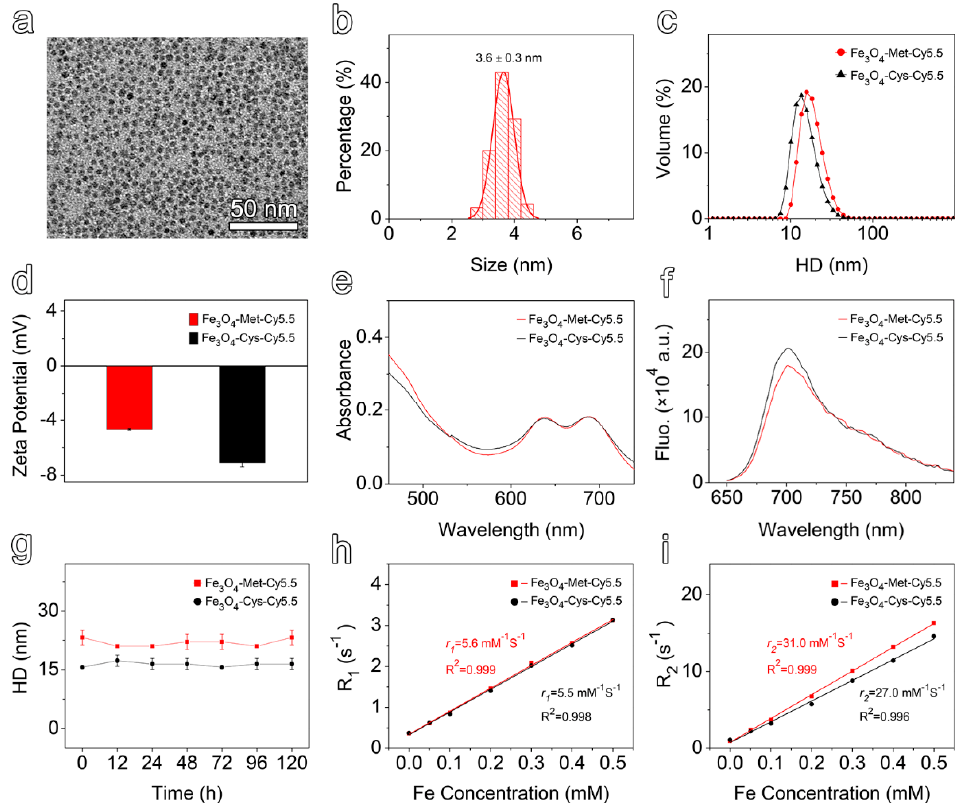
Figure 1. ( a ) TEM image and ( b ) size distribution of PEGylated Fe 3 O 4 -Mal nanoparticles. ( c ) Hydrodynamic size distribution and ( d ) zeta potential values of Fe 3 O 4 -Met-Cy5.5 and Fe 3 O 4 -Cys-Cy5.5. ( e ) Ultraviolet–visible absorption spectra of Fe 3 O 4 -Met-Cy5.5 and Fe 3 O 4 -Cys-Cy5.5, with a Fe concentration of 50 μ g mL − 1 . ( f ) Fluorescence spectra of Fe 3 O 4 -Met-Cy5.5 and Fe 3 O 4 -Cys-Cy5.5, with a Fe concentration of 50 μ g mL − 1 acquired at 705 nm upon excitation at 635 nm. ( g ) The hydrodynamic size variation of Fe 3 O 4 -Met-Cy5.5 and Fe 3 O 4 -Cys-Cy5.5 incubated in PBS for 120 h. Linear regression fitting of the longitudinal ( h ) and transverse ( i ) relaxivities of Fe 3 O 4 -Met-Cy5.5 and Fe 3 O 4 -Cys-Cy5.5 for extracting r 1 and r 2 .